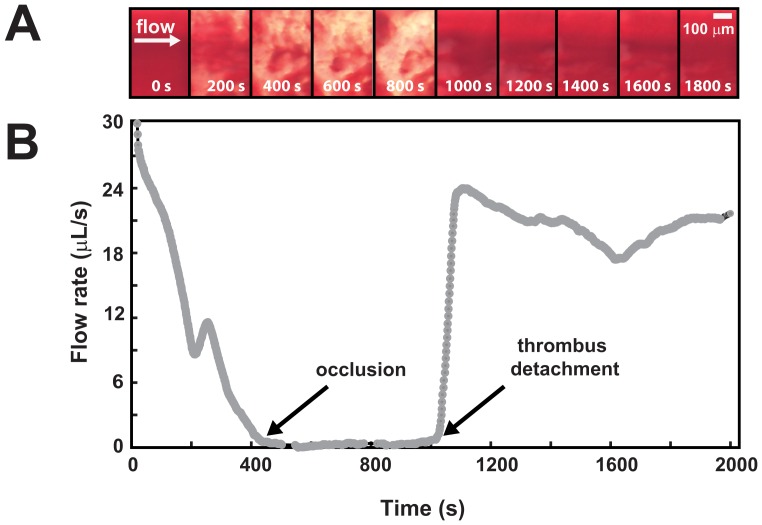
Formation and measurement of thrombus in a channel run within the microfluidic device measured using both microscopy and flow rate at 10000−1 initial shear rate.Microscopy images (A) show aggregation initiation at the entry of the stenosis, where brighter areas of the images correspond to more platelet mass. Time stamps for images in seconds are shown at the bottom of each image, and correspond with the time axis shown below in (B). As platelets aggregate, the flow rate (B) decreases until it reaches occlusion time. The unstable thrombus detaches, indicated by the sudden increase in flow rate.